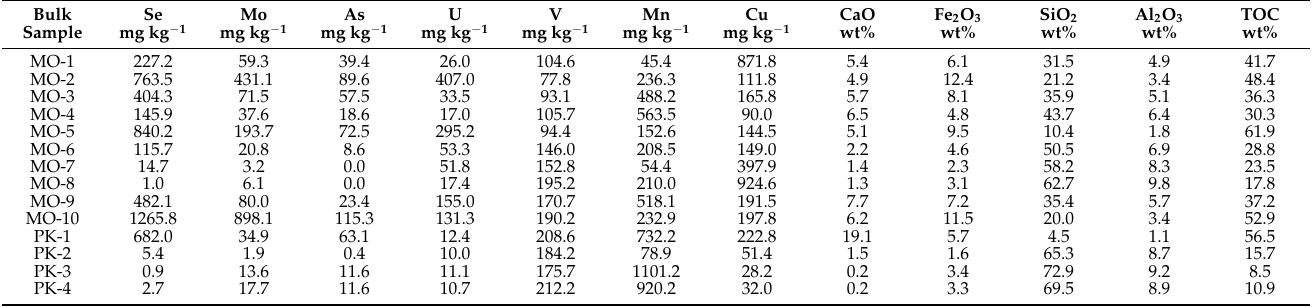
Table A1. X-ray fluorescence data showing the concentration of selected major and trace elements in soil samples collected at 10–20 cm depth at sites MO and PK. TOC by loss on ignition.